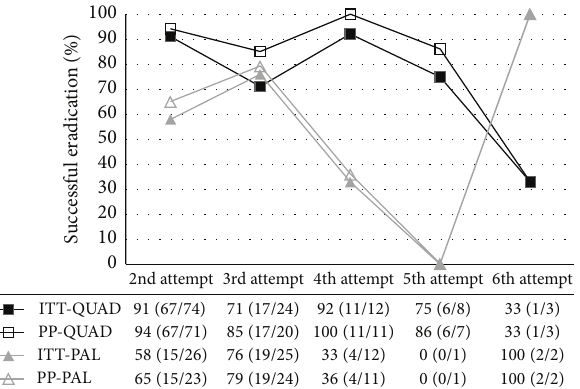
Figure 6: Bismuth quadruple (QUAD) and levofloxacin PPI triple therapy(PAL)eradicationforeachtreatmentattempt.ITT:intention to treat analysis, PP: per protocol analysis. Overall risk difference: